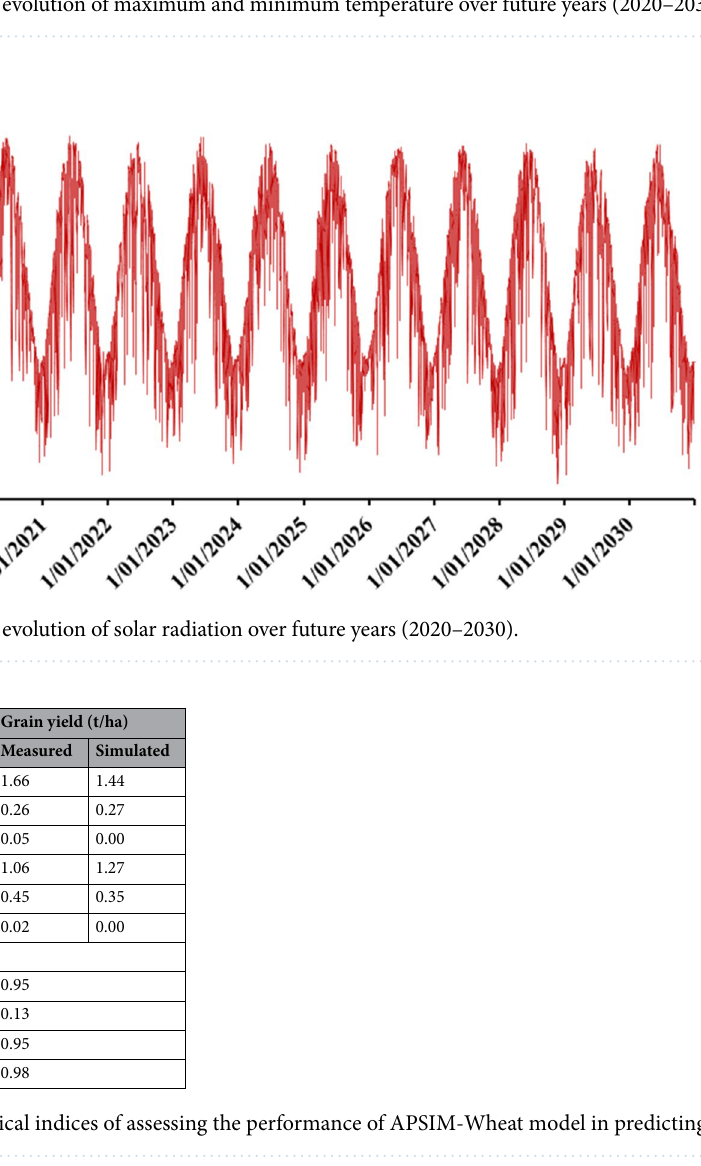
Figure 14. The evolution of maximum and minimum temperature over future years (2020–2030).